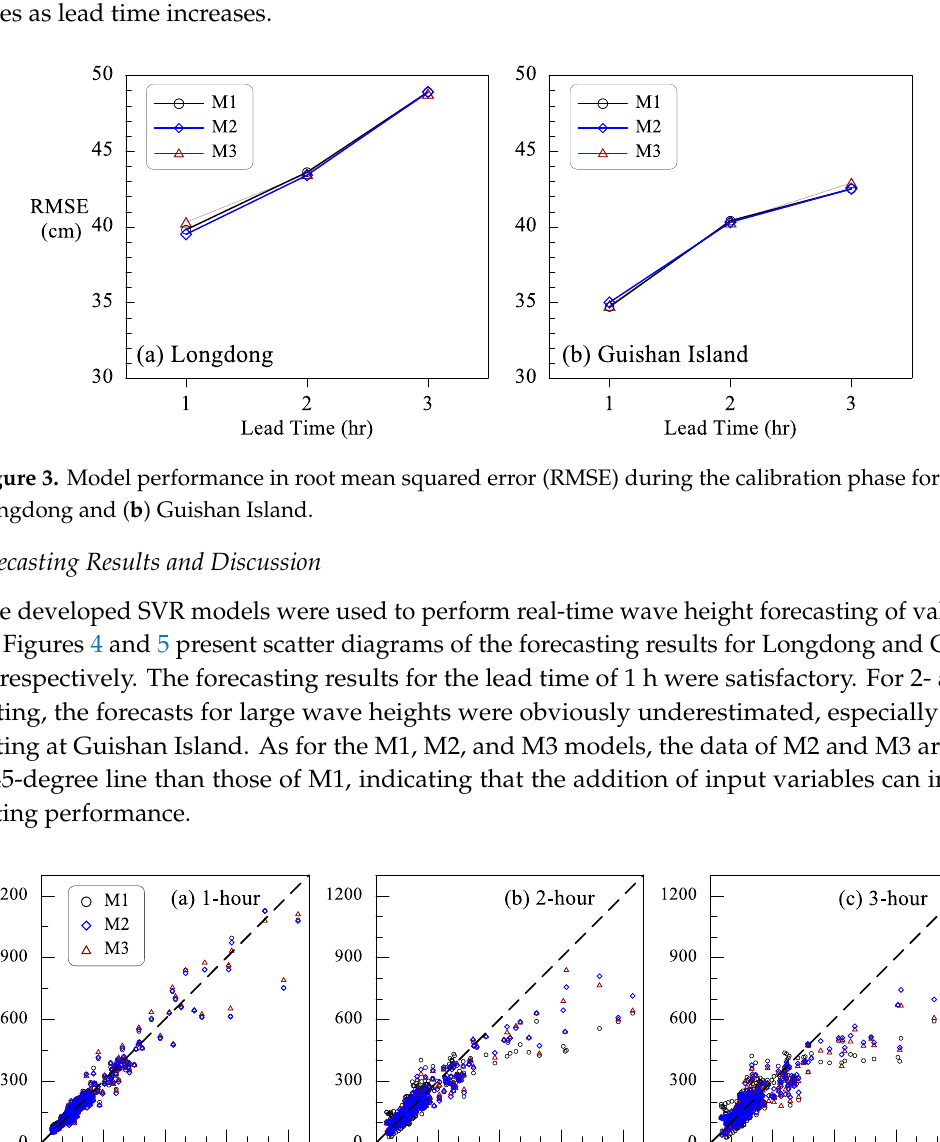
Figure 5. Forecasting results with lead time of ( a ) 1, ( b ) 2, and ( c ) 3 h for Guishan Island. Quantitative indices were used to assess the model performance. One is the RMSE, and the other is the coefficient of efficiency (CE).